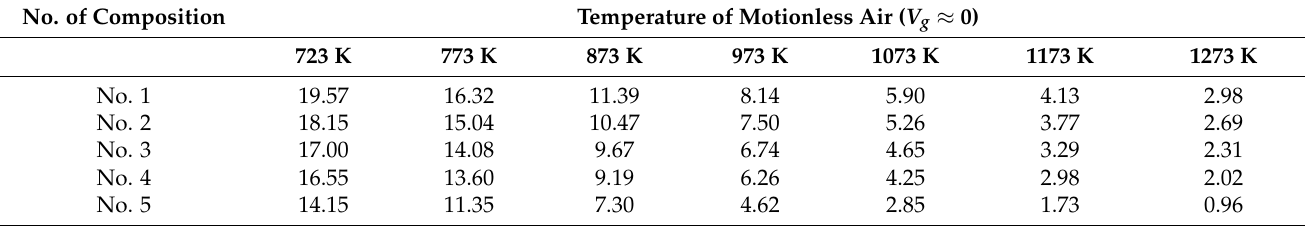
Table 3. Average ignition-delay times of CLF exposed to radiant heating ( V g ≈ 0) at different air temperatures [23].